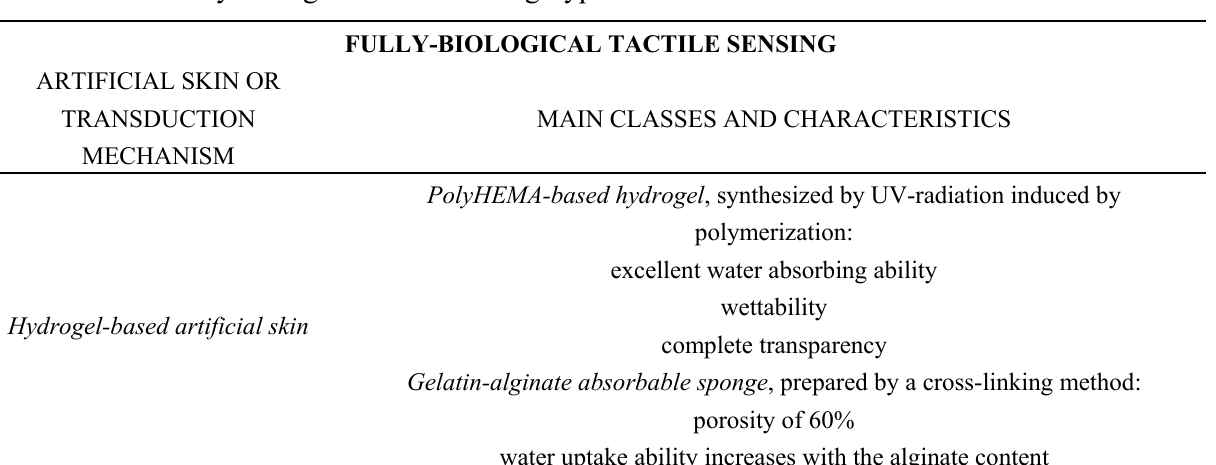
Table 4. Fully-biological tactile sensing: types of artificial skin and main